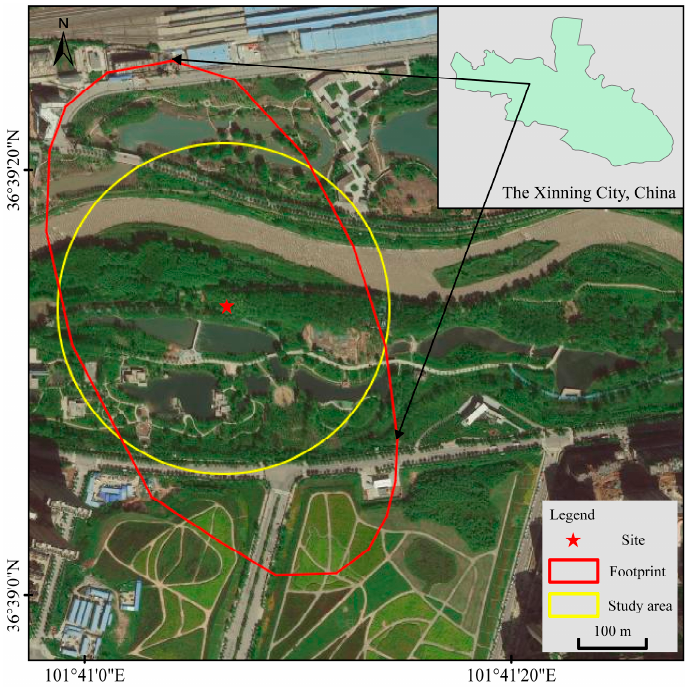
Figure 1. Map of the study